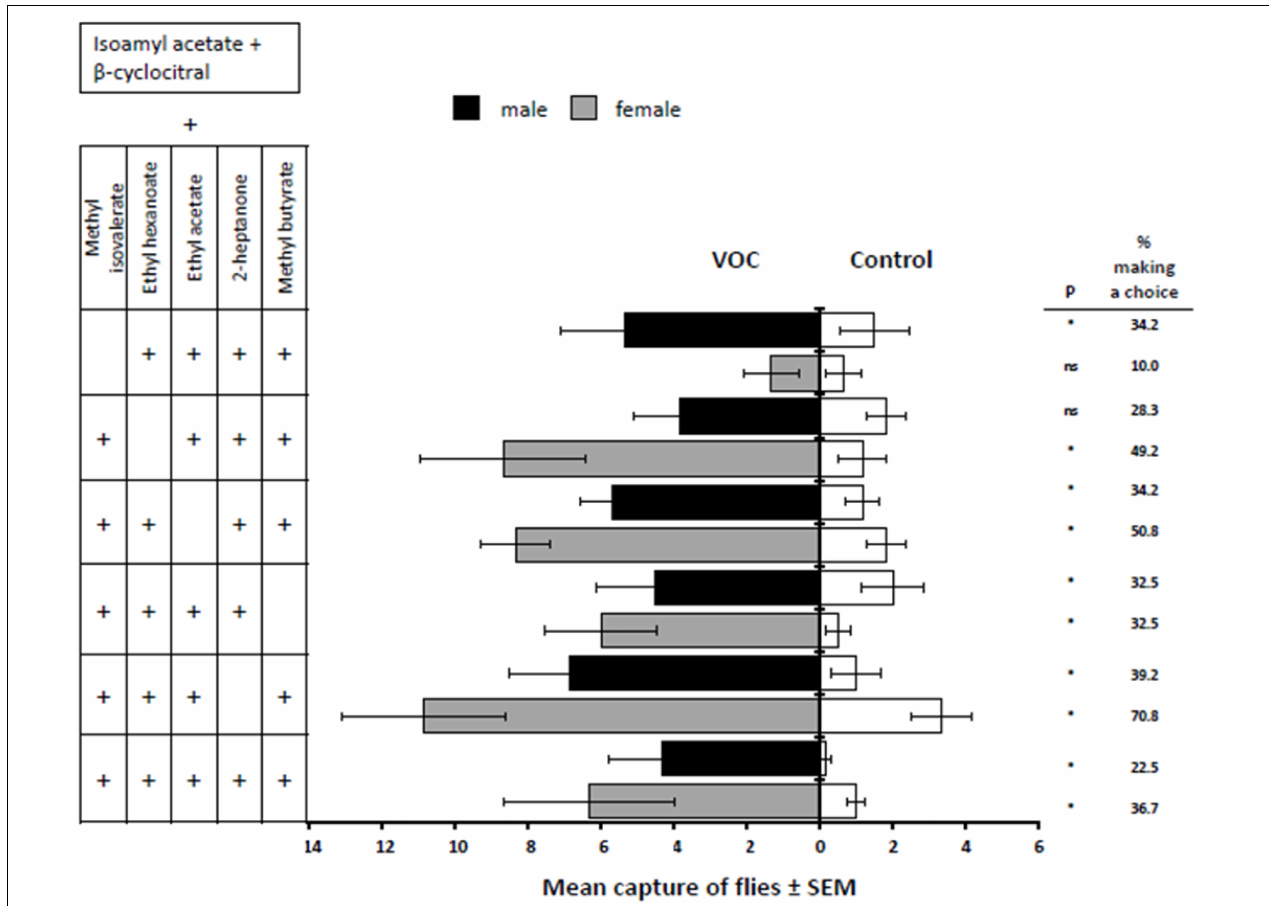
FIGURE 4 | Response of male and female D. suzukii to all selected fruit volatiles added to isoamyl acetate and β -cyclocitral (VOC) against the mineral oil solvent (Control) and a subtraction strategy where one volatile from the entire blend was removed. P -values with ∗ indicate P < 0.05 and “ns” indicates a non-significant difference where P >